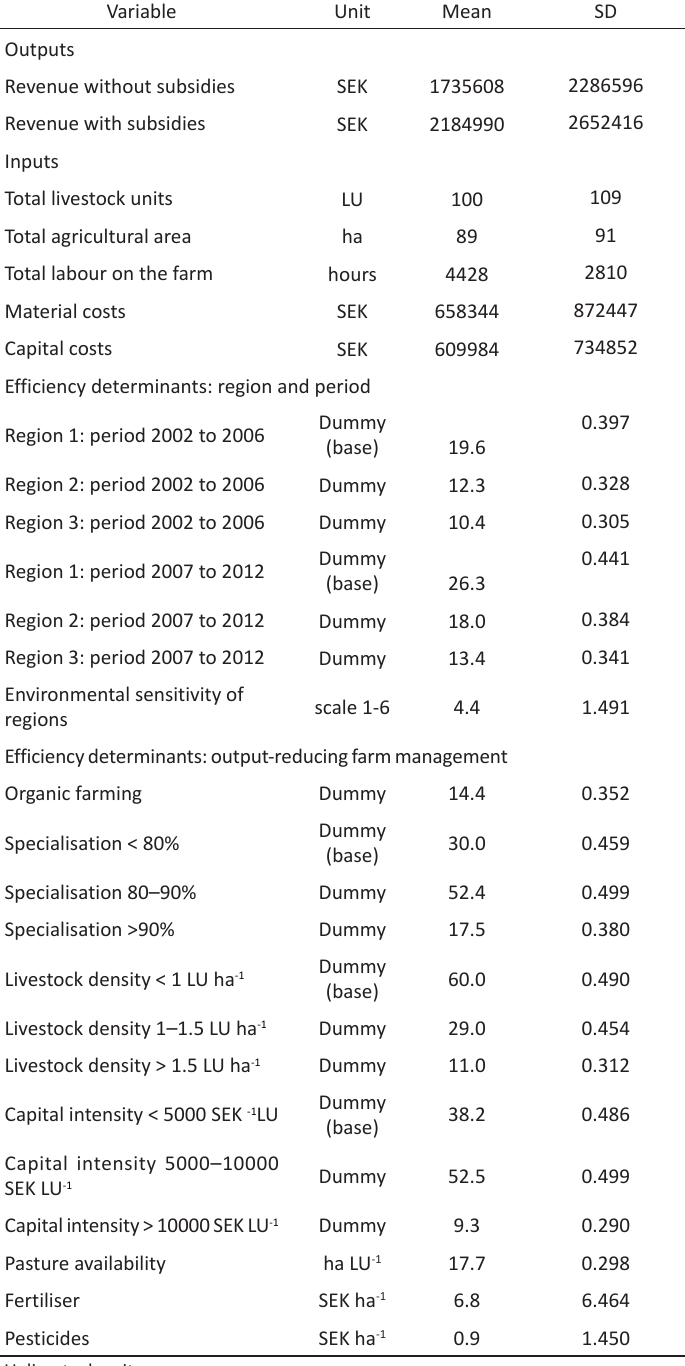
Table 1. Descriptive statistics: Input-output variables and efficiency